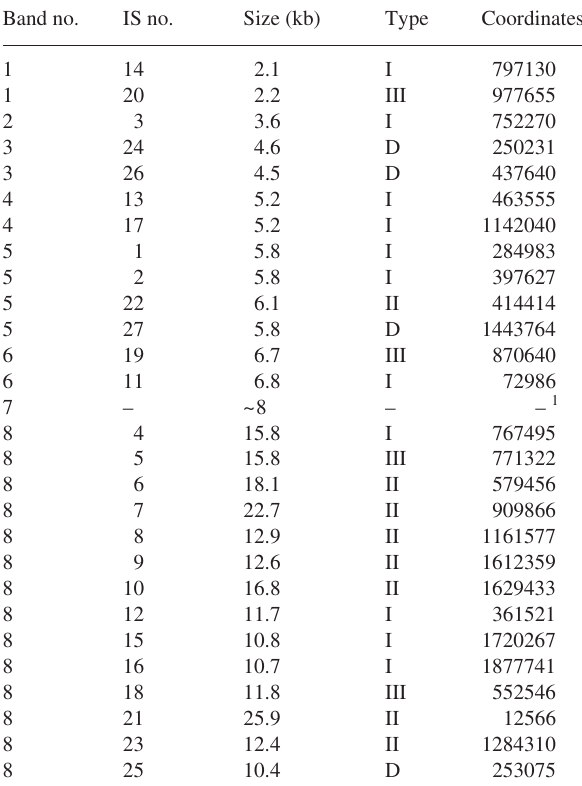
Table 2. Element numbers (IS no.), coordinates and predicted Pst I re- strictionfragmentsizes (kb). Sizes of fragmentscontaininga singleIS element sequence were calculated from the two nearest Pst I restric- tion sites flanking an IS element sequence. Band nos. are numbers as- signed to the bands observed in lane 2 of Figure 3.